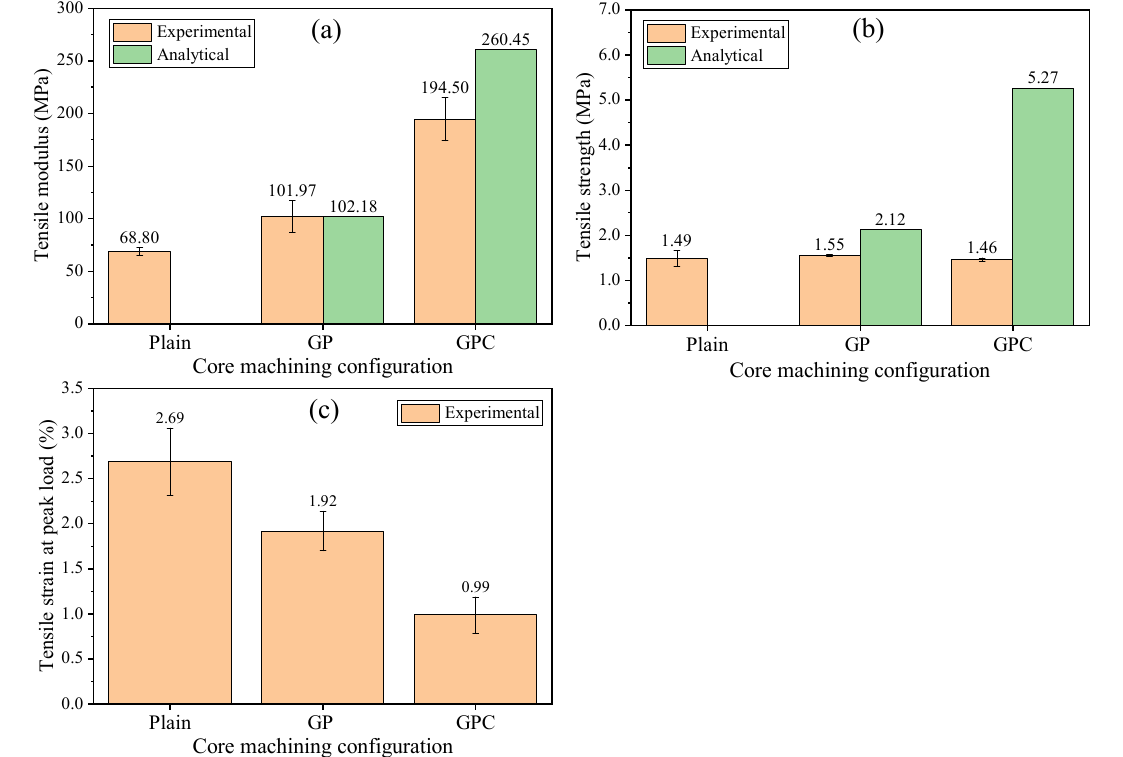
Figure 7. The tensile properties of the plain, GP, and GPC cores: ( a ) modulus, ( b ) strength, and ( c ) strain at the peak load.